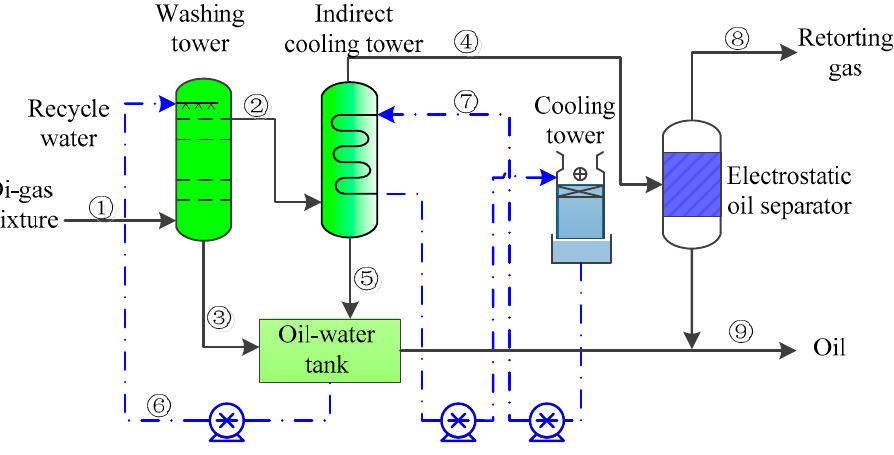
Figure 4. Flow diagram of oil-gas separation unit.